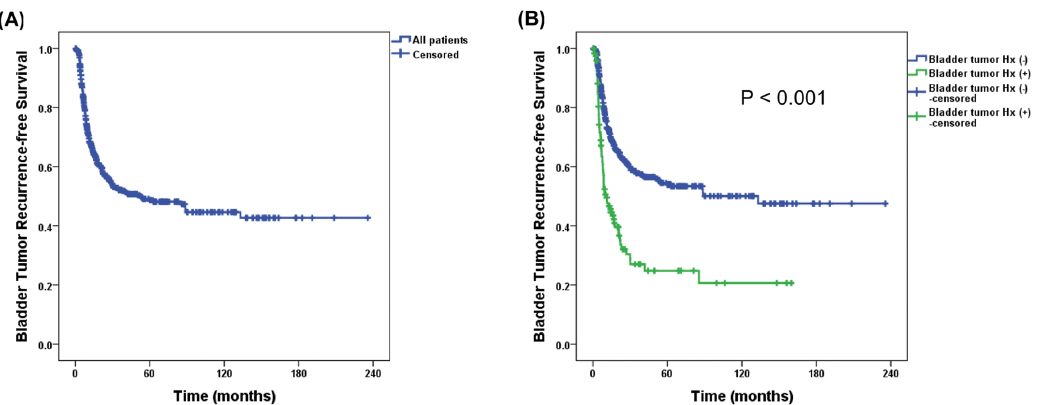
Fig 1. Survival analysis of intravesical recurrence in all patients (A), and according to previous bladder tumor history (B) following radical nephroureterectomy.